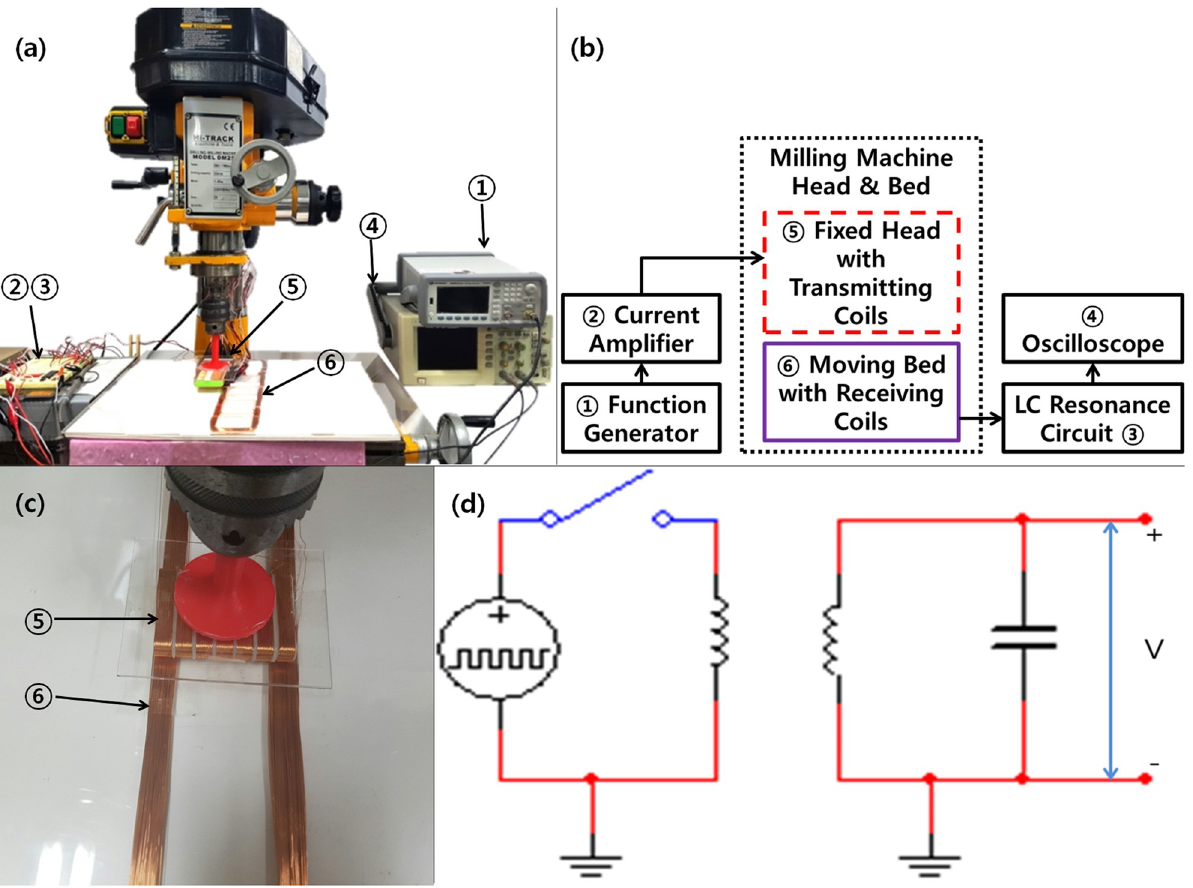
Fig 4. Developed experimental device that is measured position detection performance. (a) experimental device consist of manual milling machine, function generator, oscilloscope and auxiliary electrical circuitry (b) schematic diagram of system configuration (Fig 4a) (c) transmitting coil align with receiving coils (d) briefly drawn electrical circuit of experimental